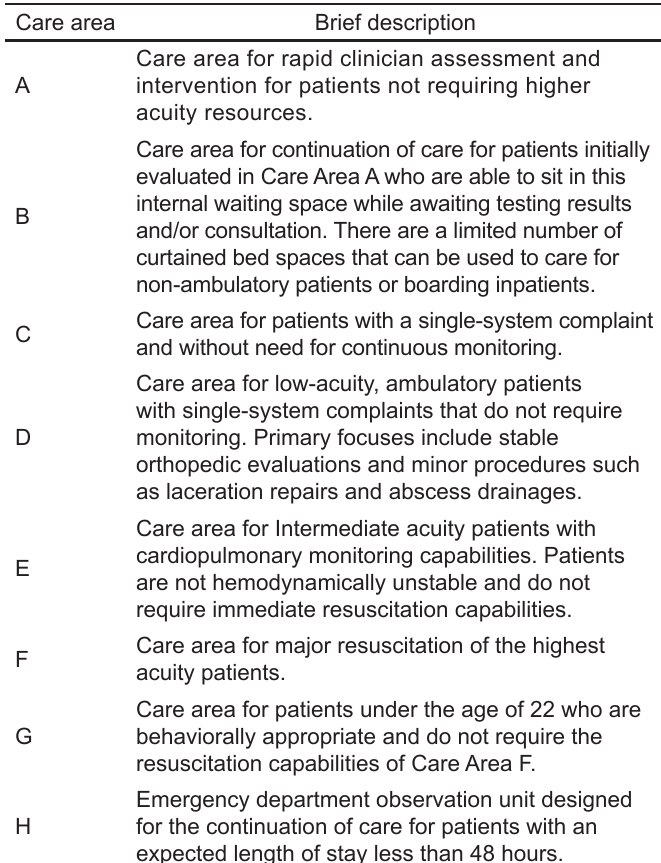
Table 1. Description of emergency department care areas.